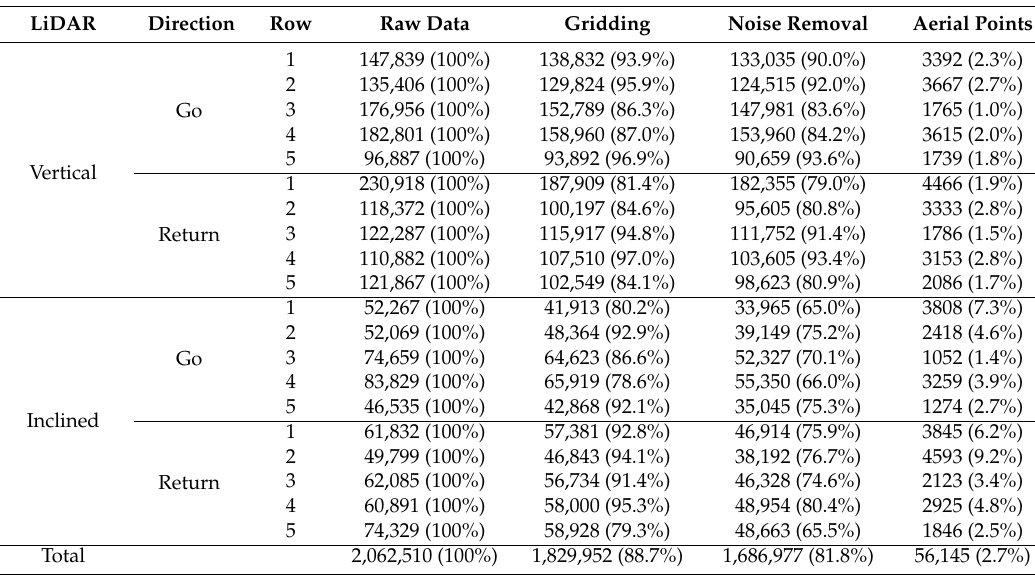
Table 5. Point cloud reduction during aerial point cloud